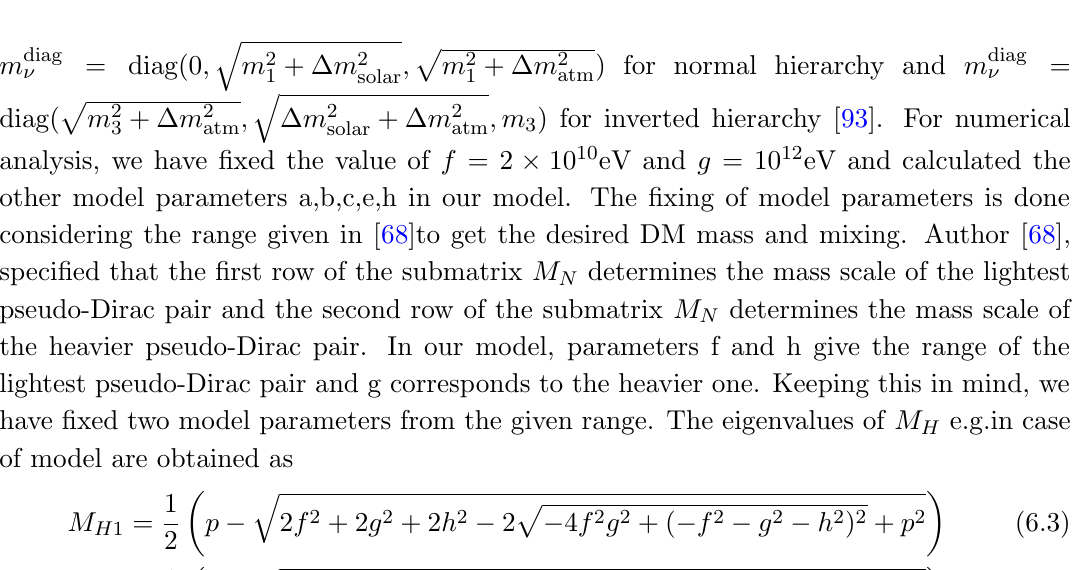
Table 3 . Latest Global (cid:12)t neutrino oscillation Data